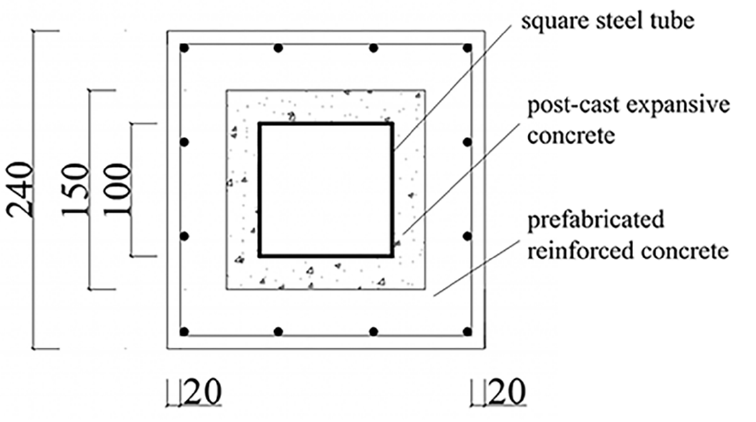
Figure 12. Section schematic of the vertical part of the prefabricated cantilever components (unit: mm).